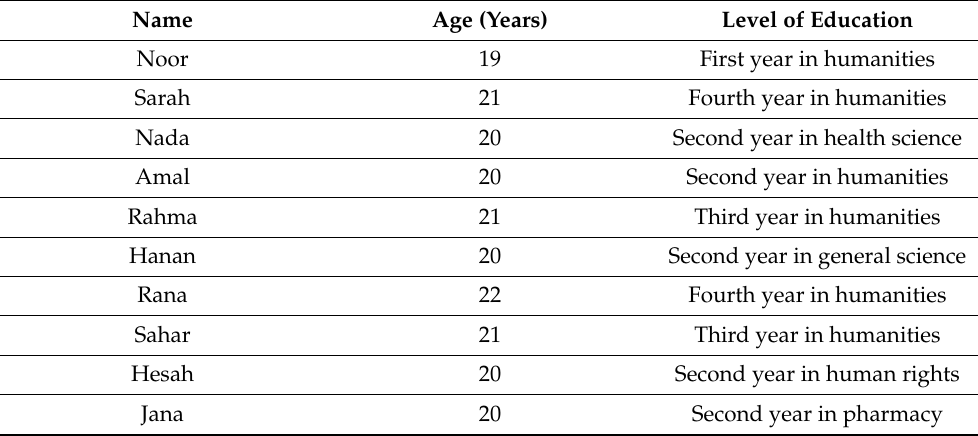
Table 1. Available demographic information for